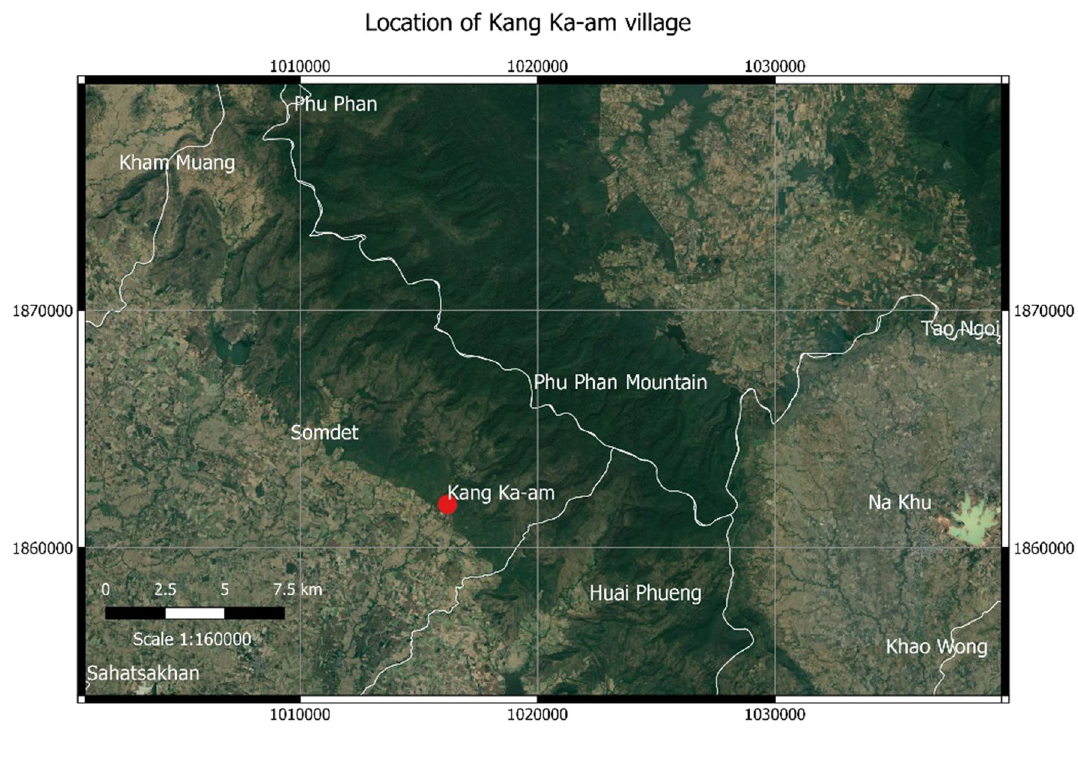
Fig. 2 Location of Kang Ka-am village